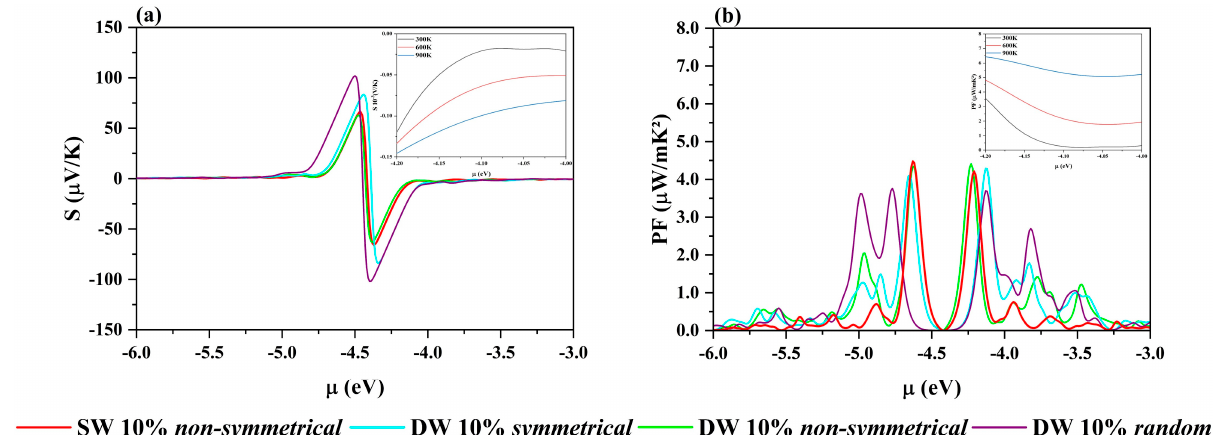
Figure 4. ( a ) Seebeck coefficient (µV/K) and ( b ) power factor ( μ W/mK 2 ) of single – (in red) and double–wall nanotubes with 10% BN with different doping patterns: symmetrical in cyan, non–symmetrical in green, and random in purple. Inset: the non–symmetrical C@(BN) 0.10 C 0.90 at different temperatures for the value of the chemical potential − 4.20 eV, corresponding to a carrier concentration of − 3.75 10 − 22 .